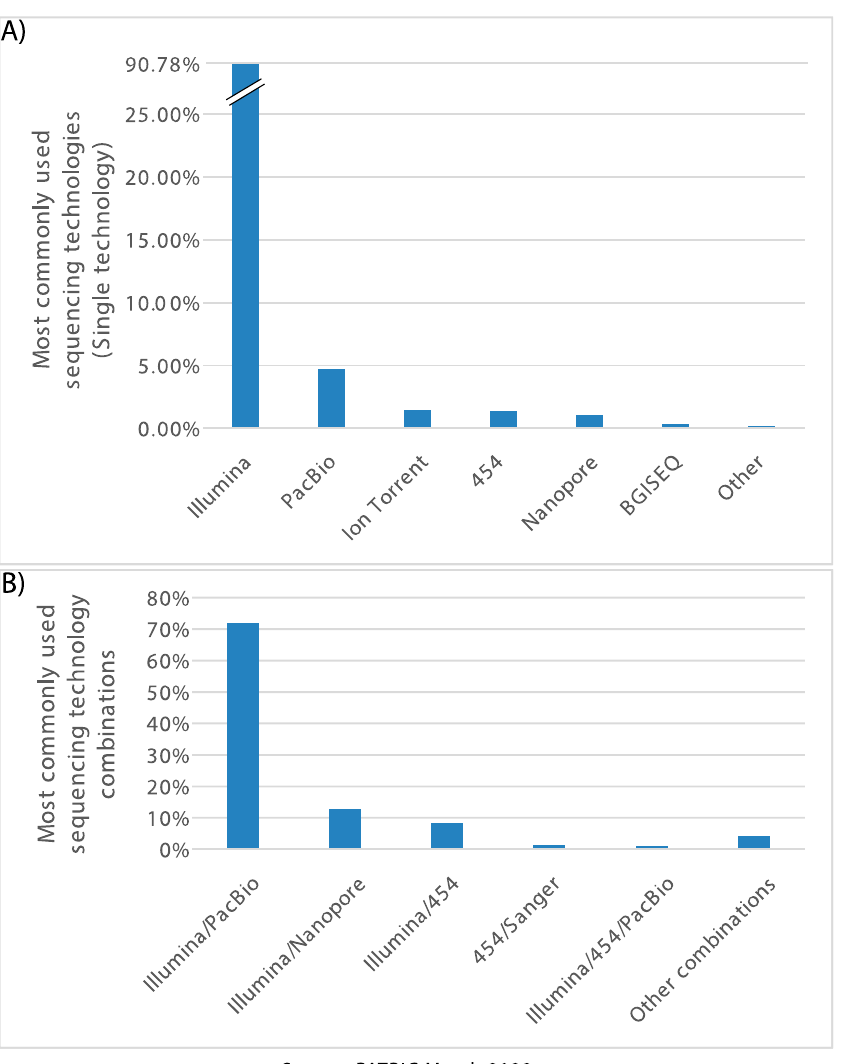
Figure 1. Most frequently used sequencing platforms according to PATRIC, for bacterial pathogens, ( A ) used as single technology and ( B ) used in combinations (hybrid approaches).